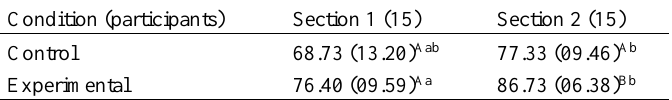
Multiple Choice Test Means (and Standard Deviations) for Composite Midterm and